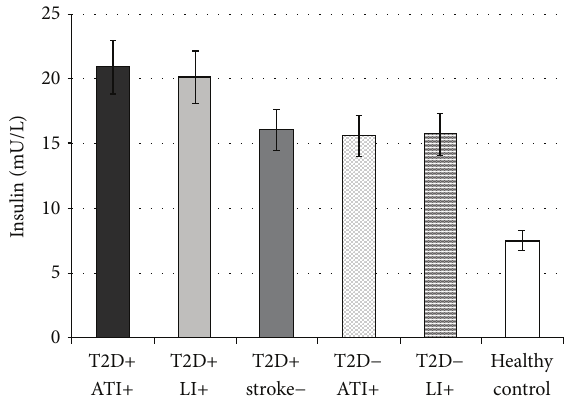
Figure 2: Values are expressed as mean ± SE. Bar graphs show the values of basal plasma insulin (PI) level. PI levels were higher in type 2 diabetic (T2D) patients with different subtypes of ischemic stroke: atherothrombotic infarction (ATI) and lacunar infarction (LI) compared to T2D patients without ischemic stroke, and the same relationship is found in the respective groups in nondiabetics ( 𝑃 < 0.001 ) (ANOVA).